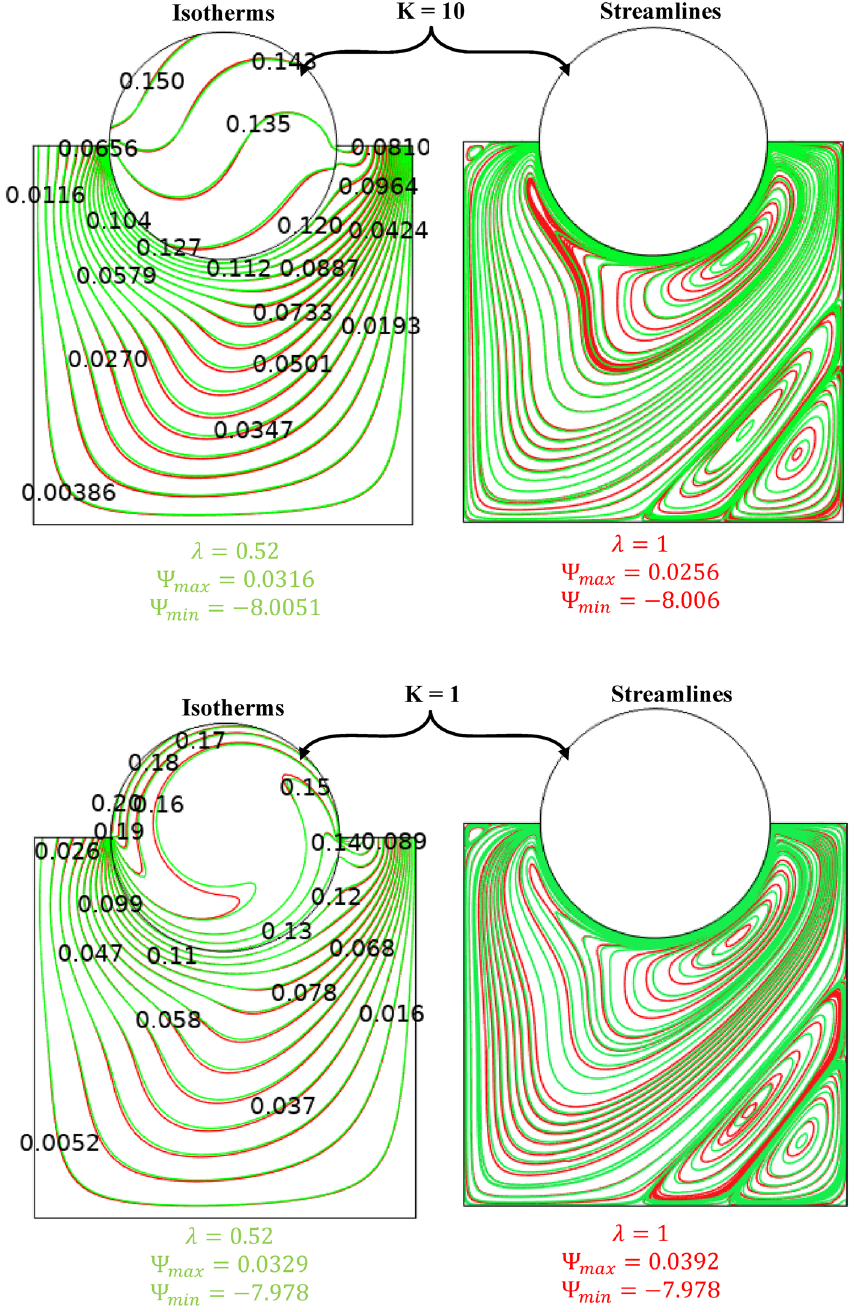
Figure 8. Isotherms and streamlines contours for different NPs shapes and thermal conductivity ratios at Ra = 10 5 , Ha = 60, and = ϕ